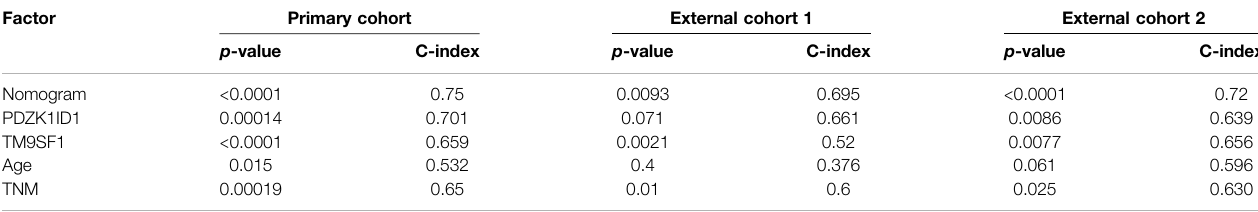
TABLE 4 | Prognostic ability and accuracy of